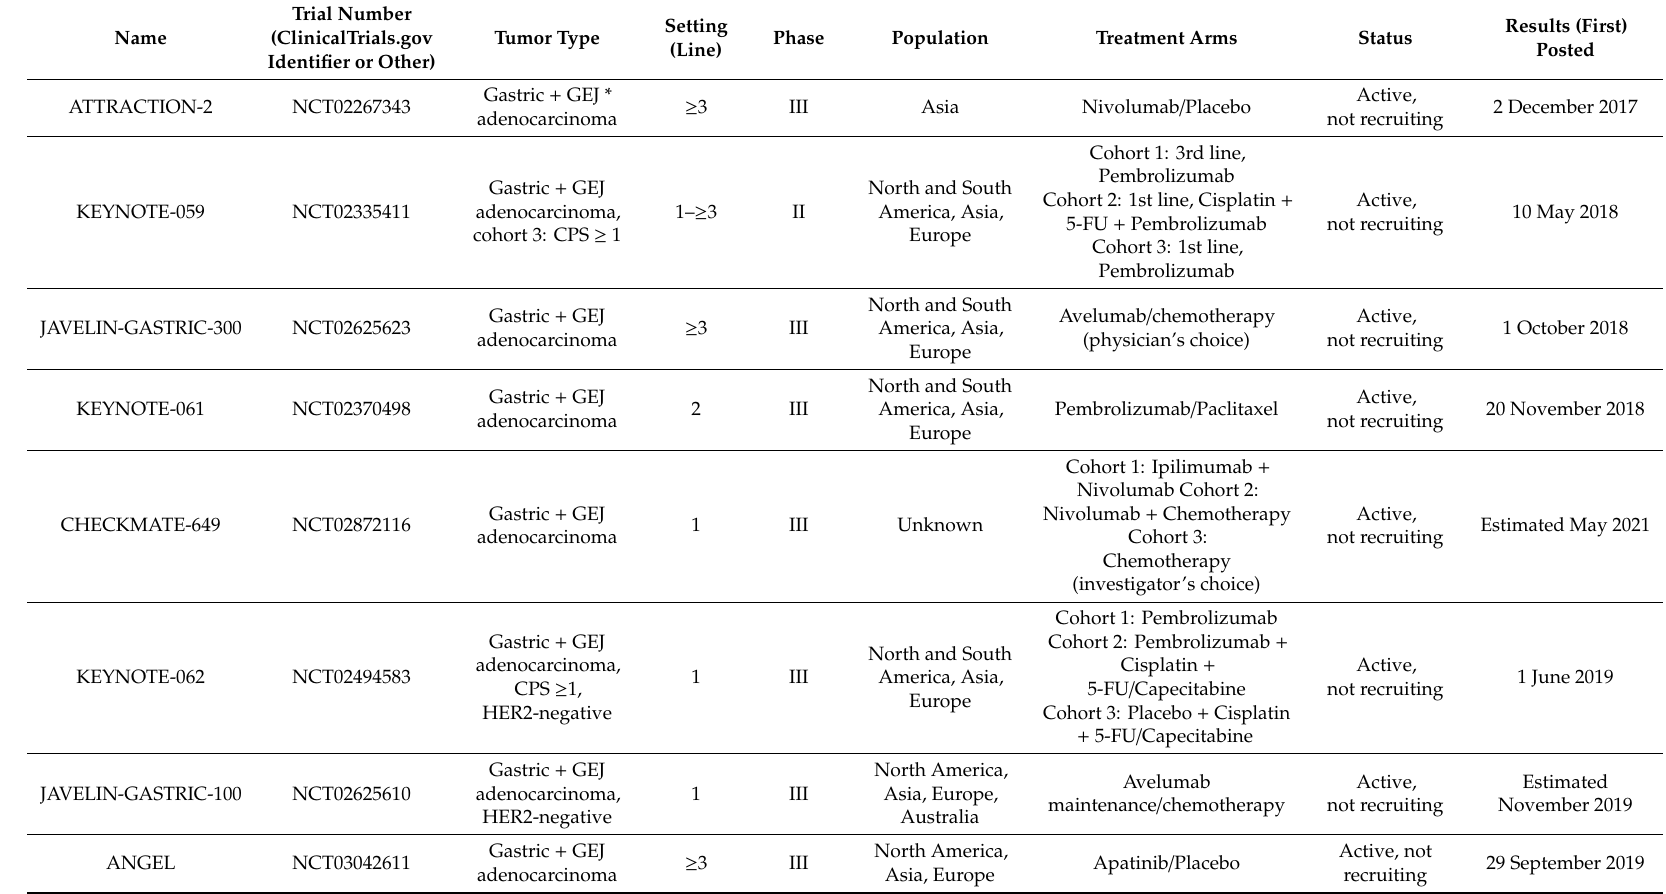
Table 1. Overview of recent trials discussed in this